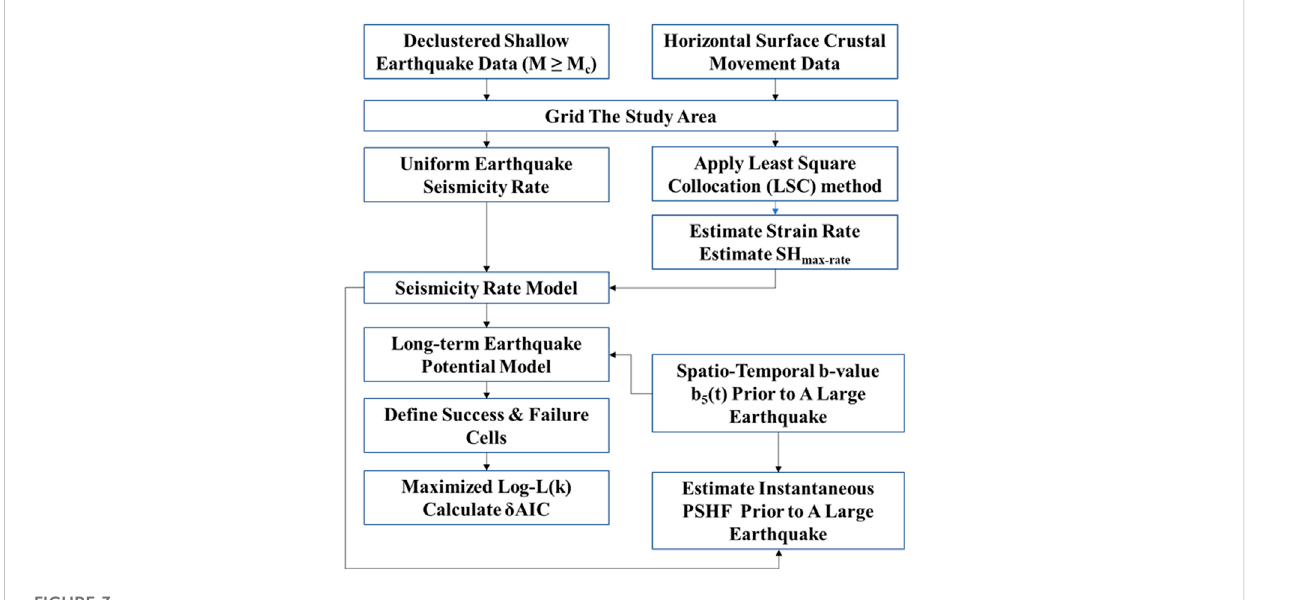
The proposed work fl ow is used in this